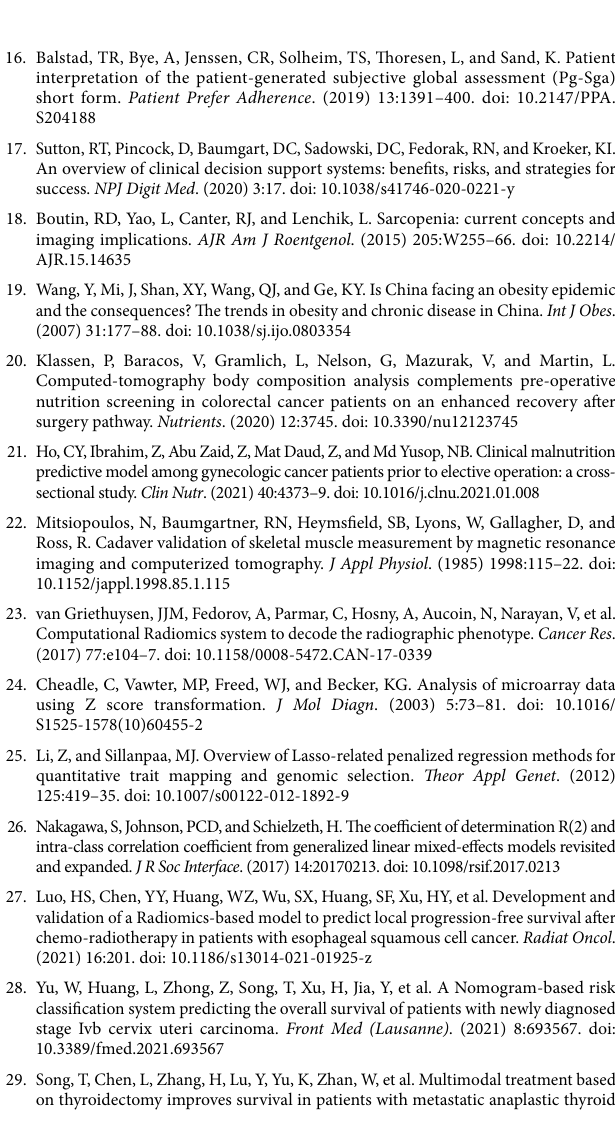
SUPPLEMENTARY FIGURE S1 Axial (a) and coronal (b) cross-sectional regions areas of the left and right psoas (green) on CT images at the L3 vertebral level. SUPPLEMENTARY FIGURE S2 The calibration curves for predicting malnutrition in the (a) training set and (b) validation set, respectively. The predicted probability (from the nomogram) and the actual probability of malnutrition are represented by the x-axis and y-axis, respectively. Results were plotted via bootstrapping with 1000 resamples. Greater prediction accuracy of the model is indicated when the bias-corrected calibration curve (black line) is close to the diagonal line. The closer the line the higher the